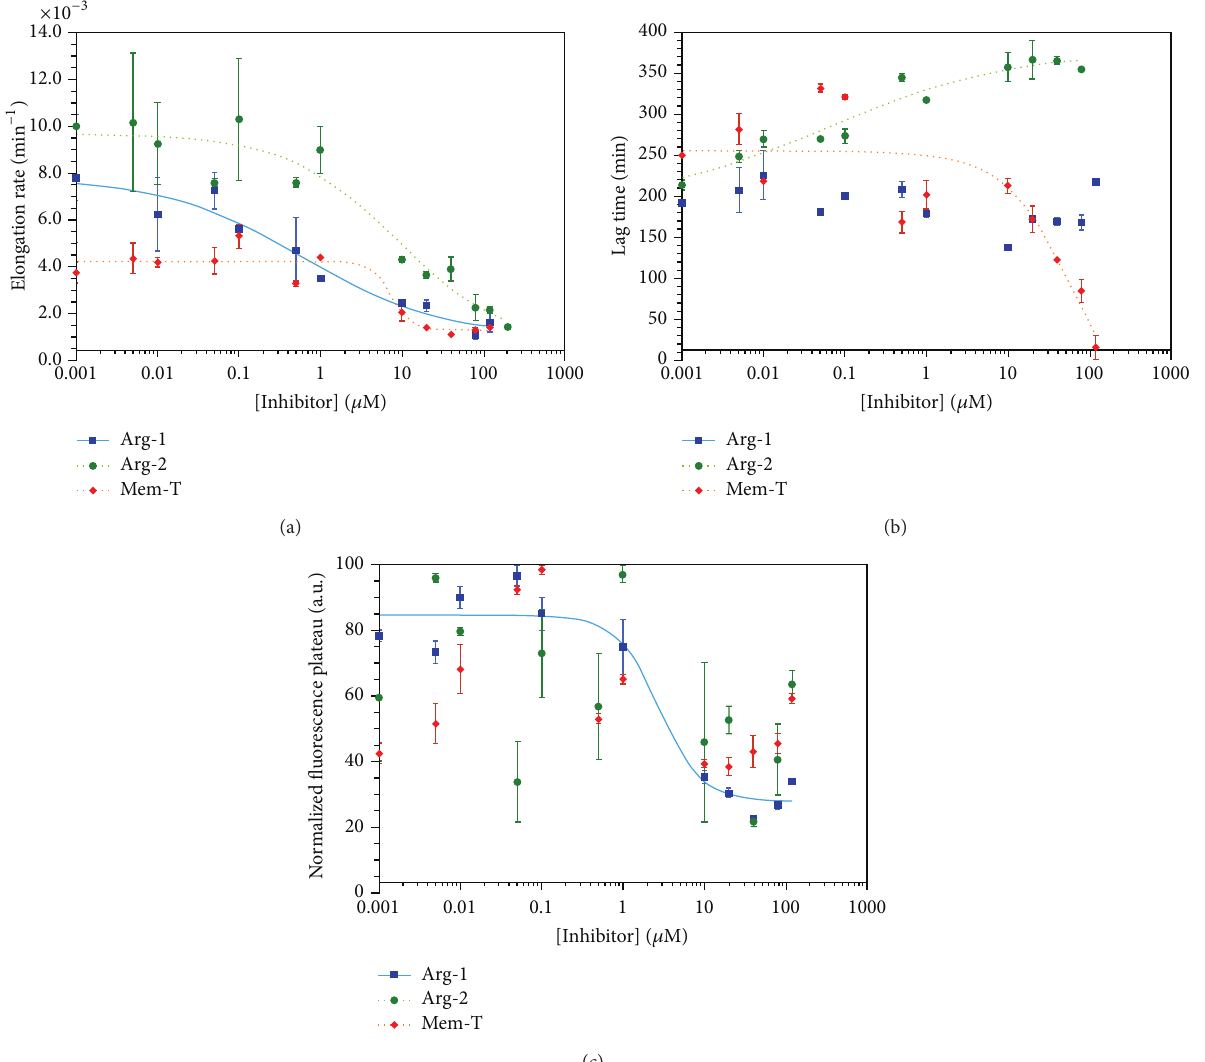
Figure 5: Effects of peptides added in trans on parameters describing the fibrillization kinetics of 20 𝜇 M WT amylin: (a) elongation rates, (b) lag times, and (c) fluorescence plateaus. Inhibition data from Arg-1, Arg-2, and Mem-T are shown in blue, green, and red, respectively. All experiments were done in duplicate in the presence of 150mM NaCl. The data points are average values for the kinetic parameters, and the uncertainty bars are SEM values calculated from duplicate reactions. Curves (where the data could be fitted) represent four-parameter nonlinear least squares fits of the inhibition data to the IC 50 equation